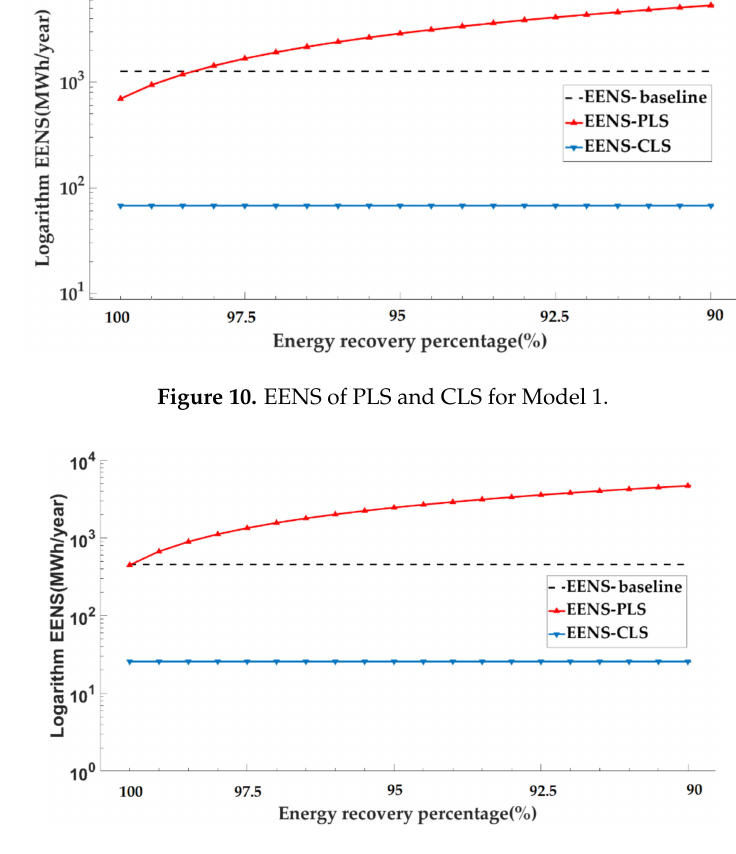
Figure 11. EENS of PLS and CLS for Model 2.